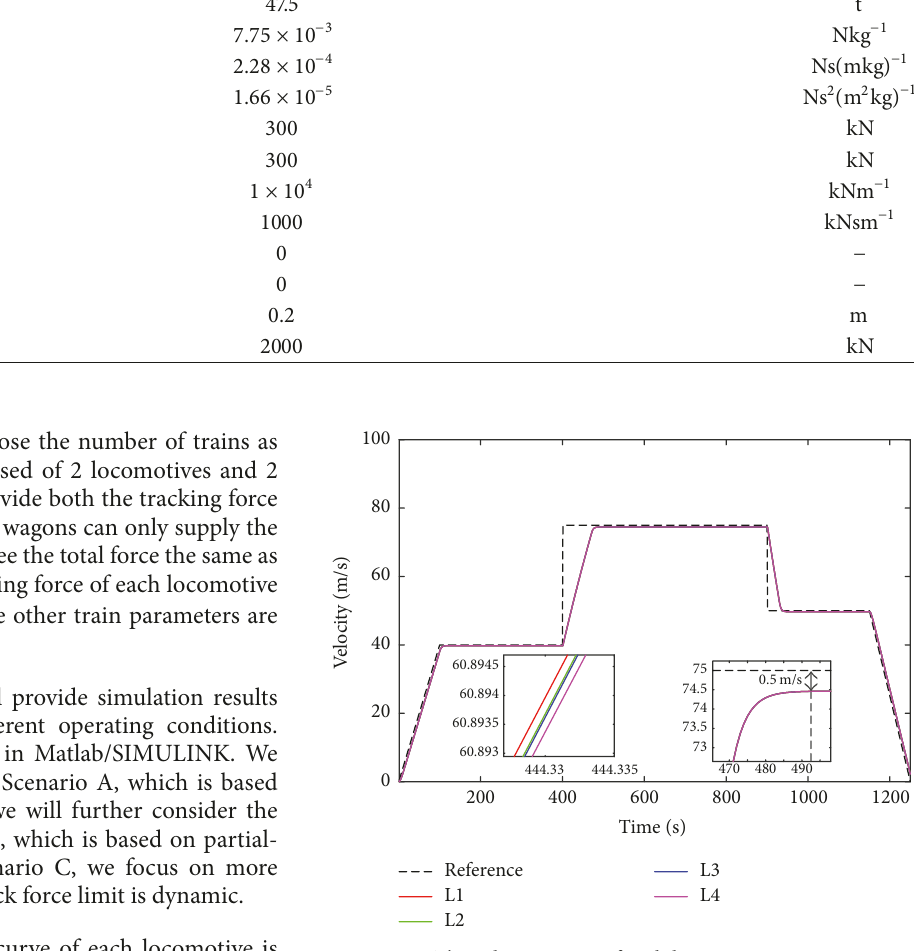
Figure 4: The velocity curve of each locomotive in Scenario